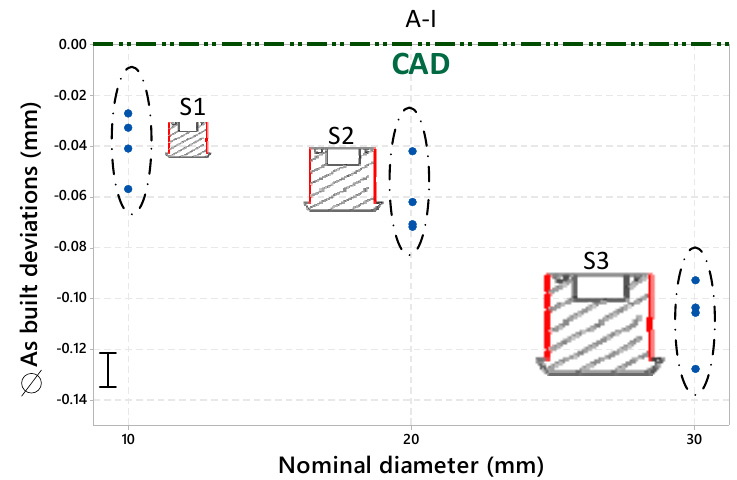
Figure 7. Inter-parts scale effects of Shape A artifacts (as-built state), based on their external diameter (highlighted in red) .